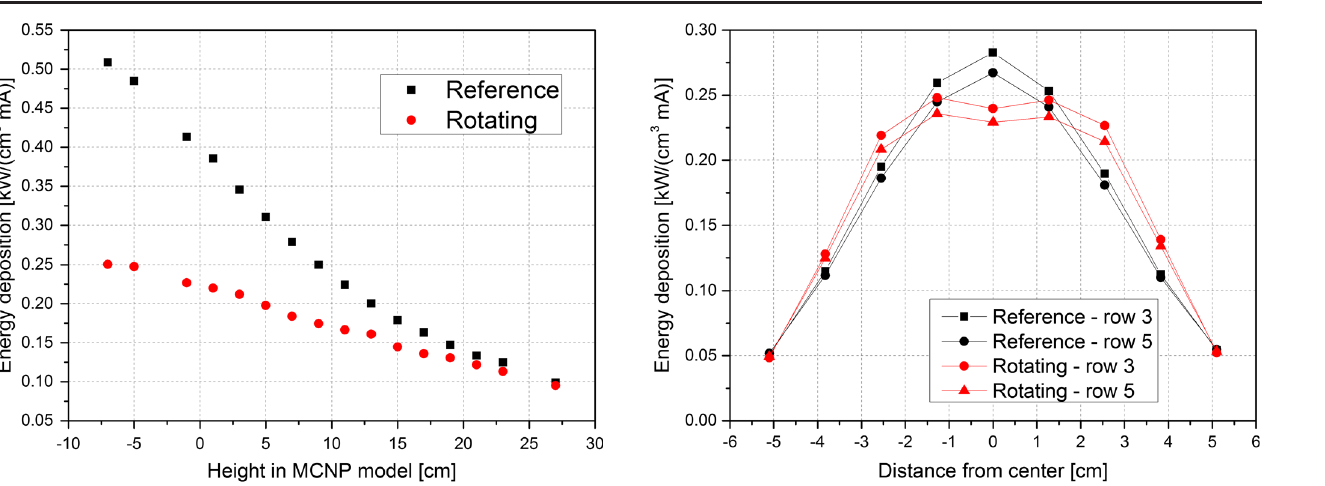
FIG. 12. Average power density in the Pb of each Cannelloni from row 3 and 5 for the reference (black symbols) and rotating beam (red symbols). The statistical error of the values is below 3%.